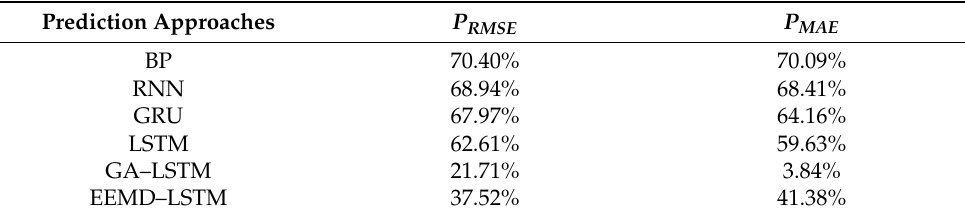
Table 5. Percentage improvements of the proposed method in comparison with the other approaches on propagation loss sequence 2 (surface duct).